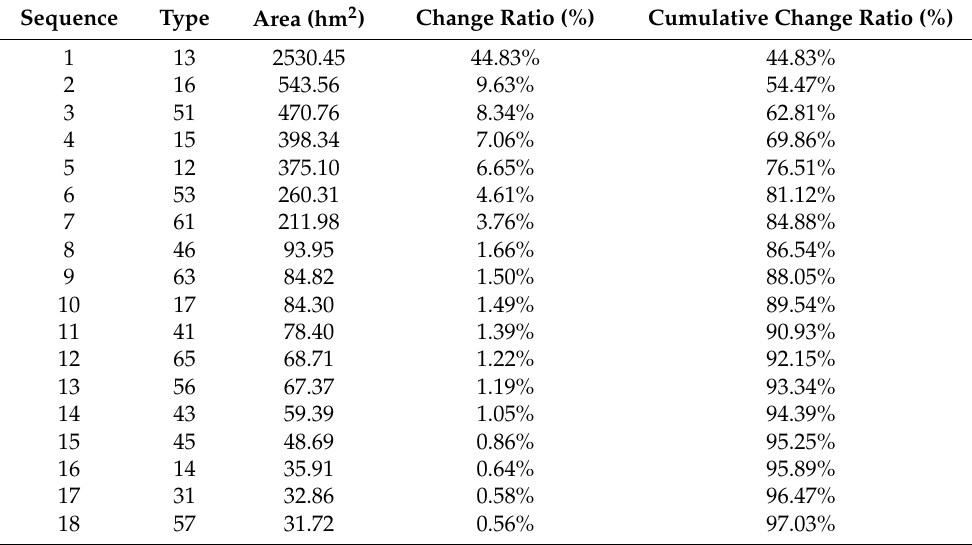
Table 2. The order of the main geographic unit of LUC in the study